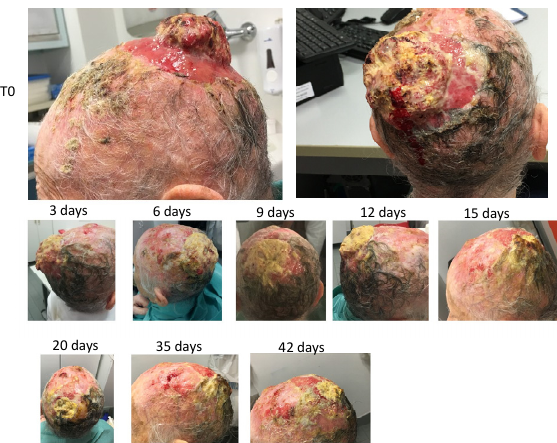
Figure 13. Evolution of a radioresistant skin basal carcinoma in a female 93-year-old patient treated with HOO.